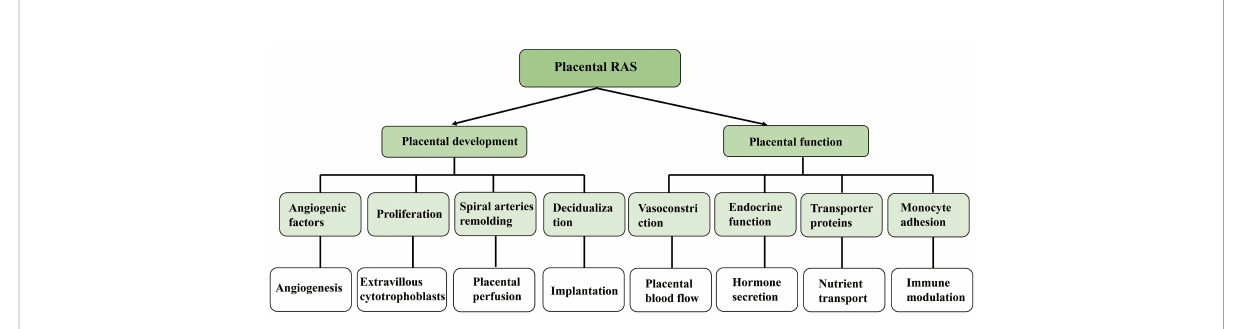
FIGURE 3 Effect and function of local renin angiotensin system on embryonic